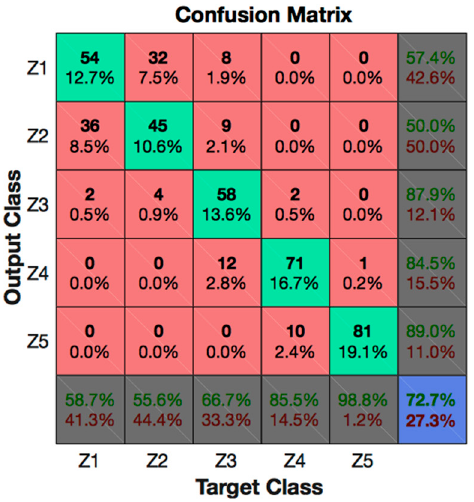
Figure 4. Confusion matrix for Z_all datasets with the CGRU model.